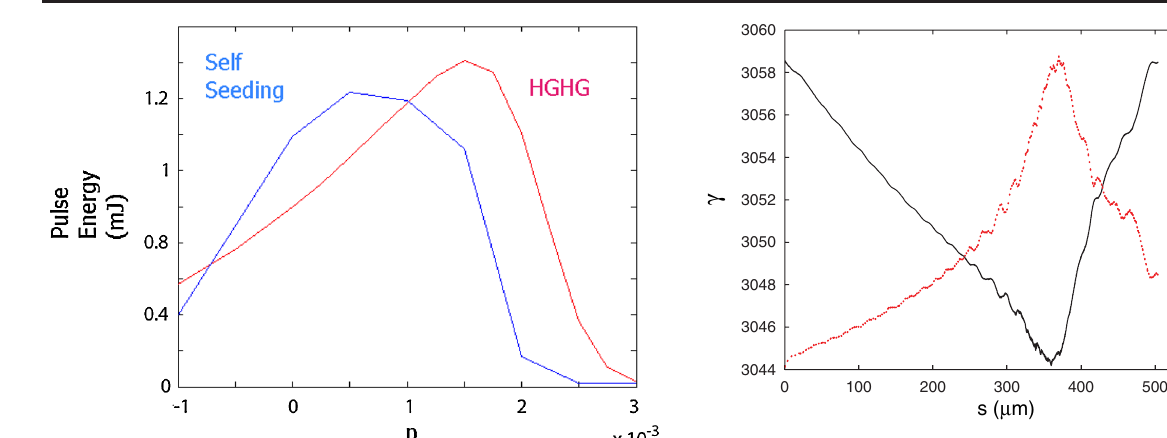
).FIG. 7. (Color) Pulse energy at the saturation point as a function of energy detuning. The results for the self-seeding are averaged over 20 independent runs.